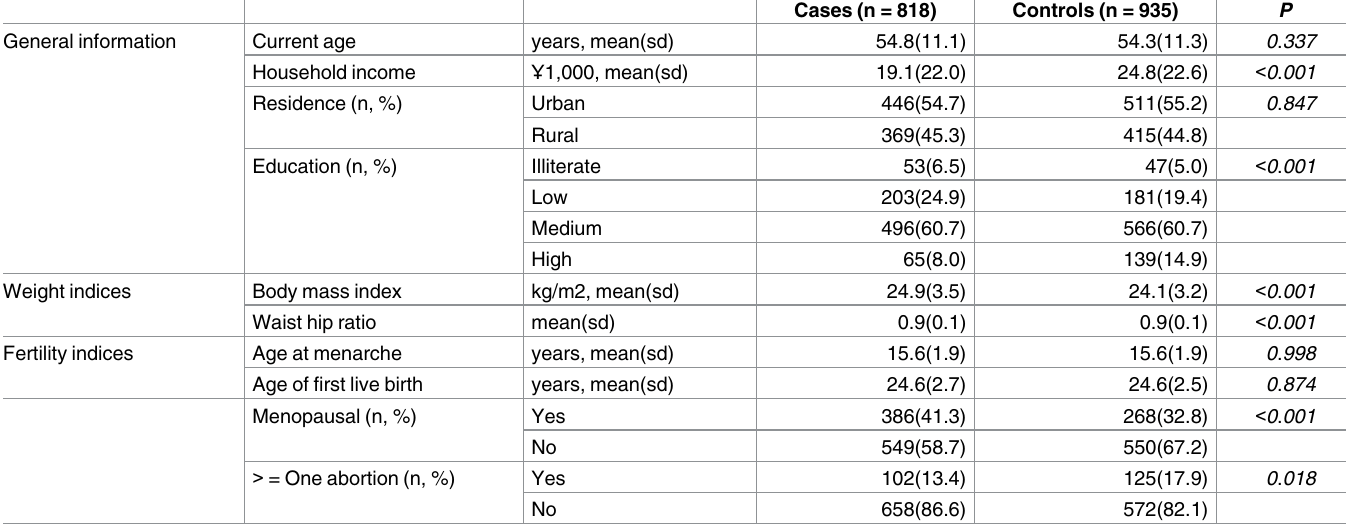
Table 1. Descriptivecharacteristics of the population by case/control